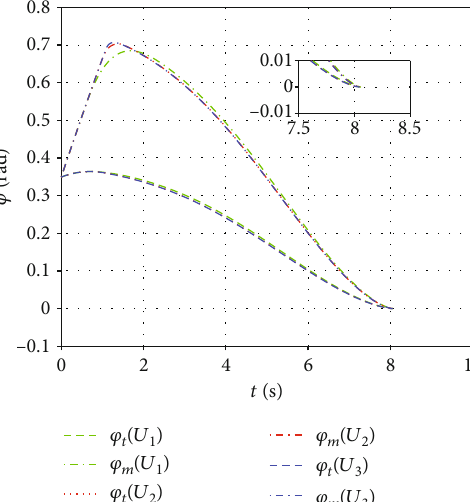
Figure 8: Direction angles φ .